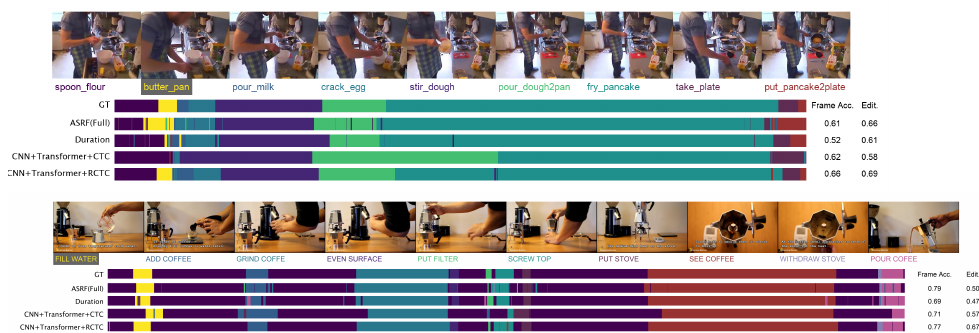
Figure 8. Frame and alignment accuracy on randomly selected testing videos from Breakfast ( Top ) and YouTube Instructions ( Bottom ), respectively. (Note: there is a background class ( ) in YouTube Instructions, usually present in between neighboring steps, whose fraction varied from 46% to 83% across different tasks, whereas Breakfast is tightly